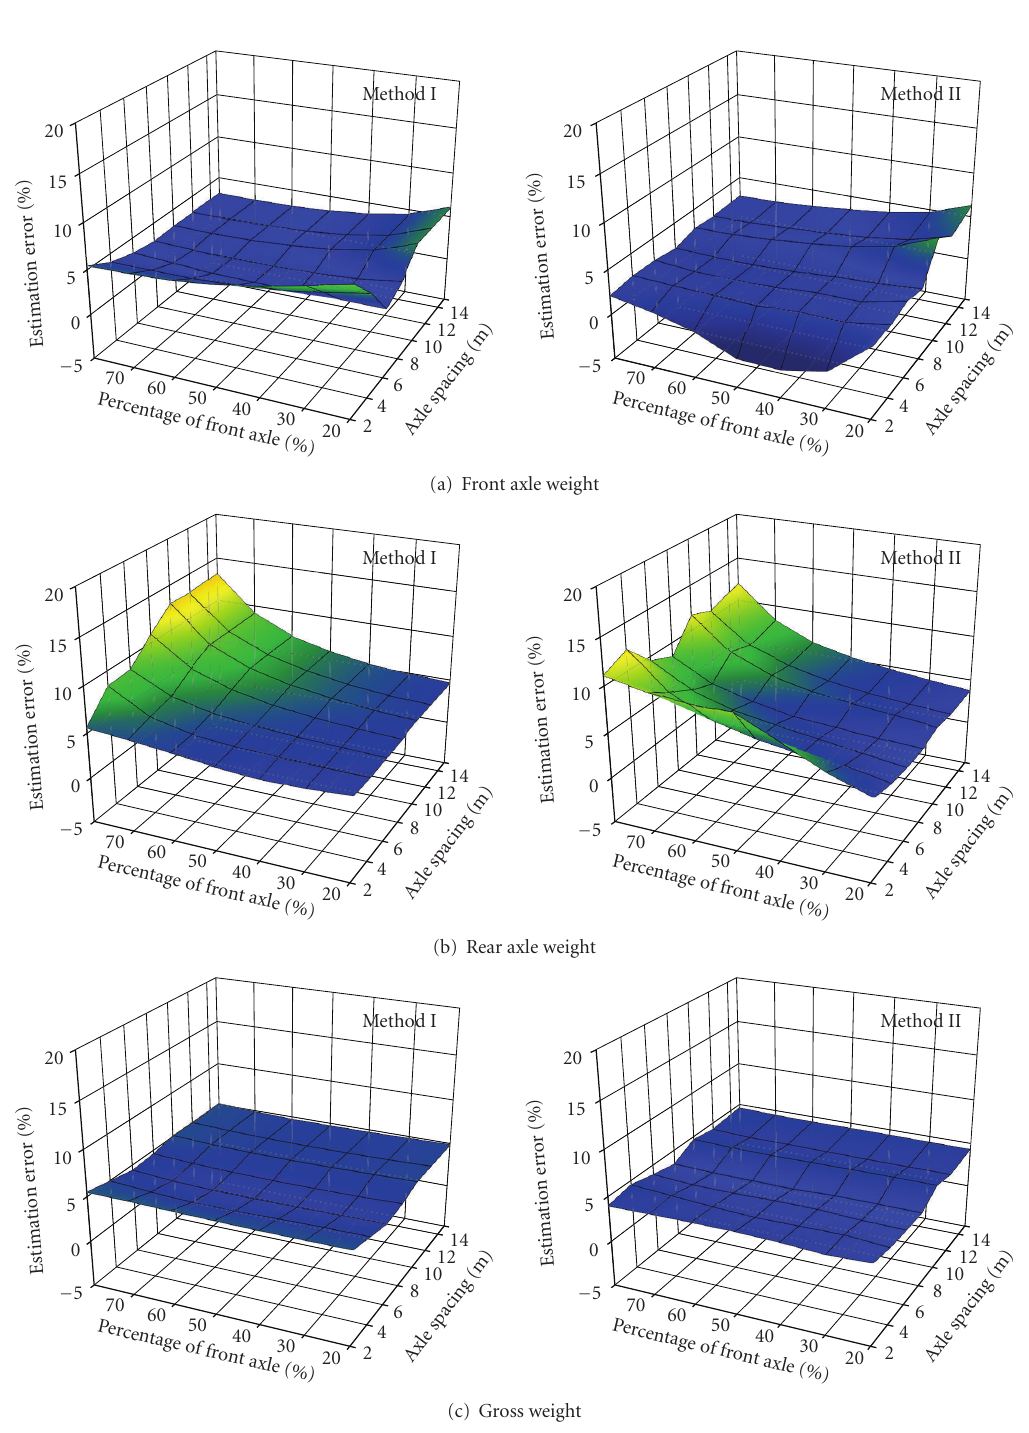
Figure 9: Estimation errors of axle weights under various axle spacings and axle weight distributions for (a) front axle weight, (b) rear axle weight, and (c) gross